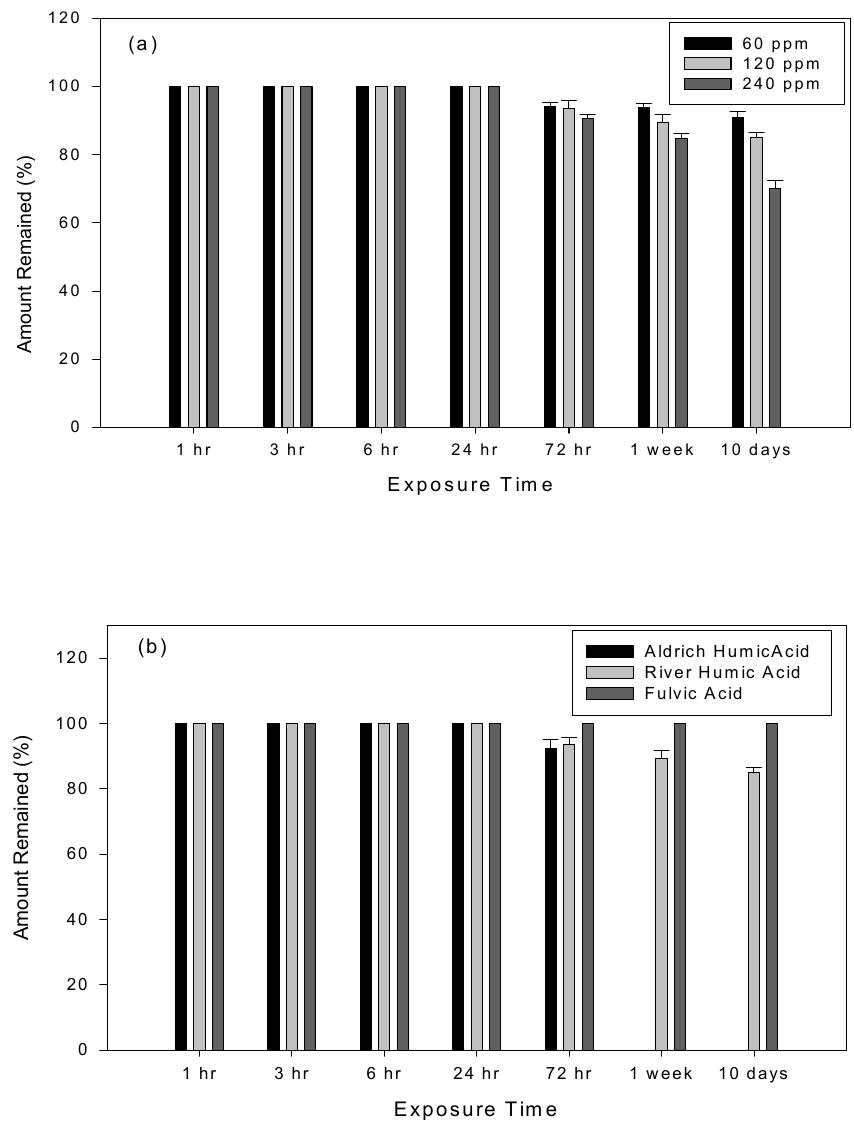
Figure 4. Photodegradation rate of atrazine (10 µ M; calculated as remained) inPBS buffer solution (pH 7.0) with different type and concentration of HA under outdoor sunlight. (a) river humic acid was added at concentration of 60, 120, 240 ppm. Atrazine remains the same at 0 ppm within 10 days (not shown here). (b) Aldrich humic acid, IHSS river humic aci and fulvic acid were addded at concentration of 120